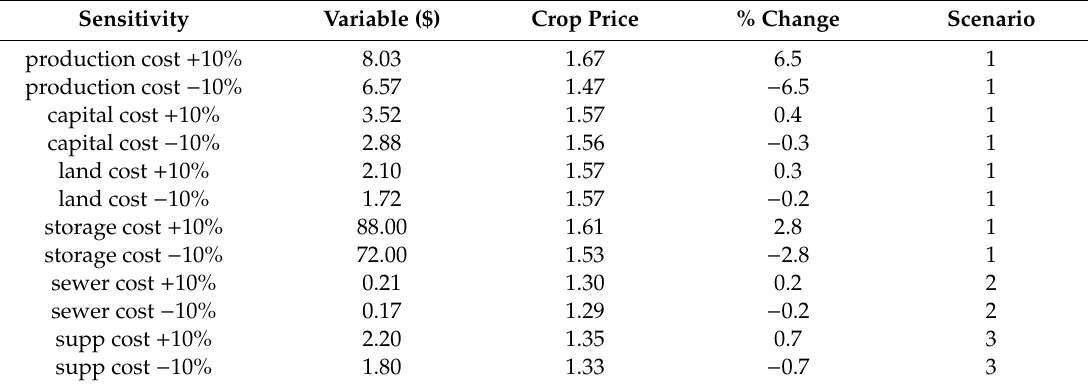
Table 5. Sensitivity analysis of SOIL-FIELD crop price to changes in economic inputs. Sensitivity Variable ($)